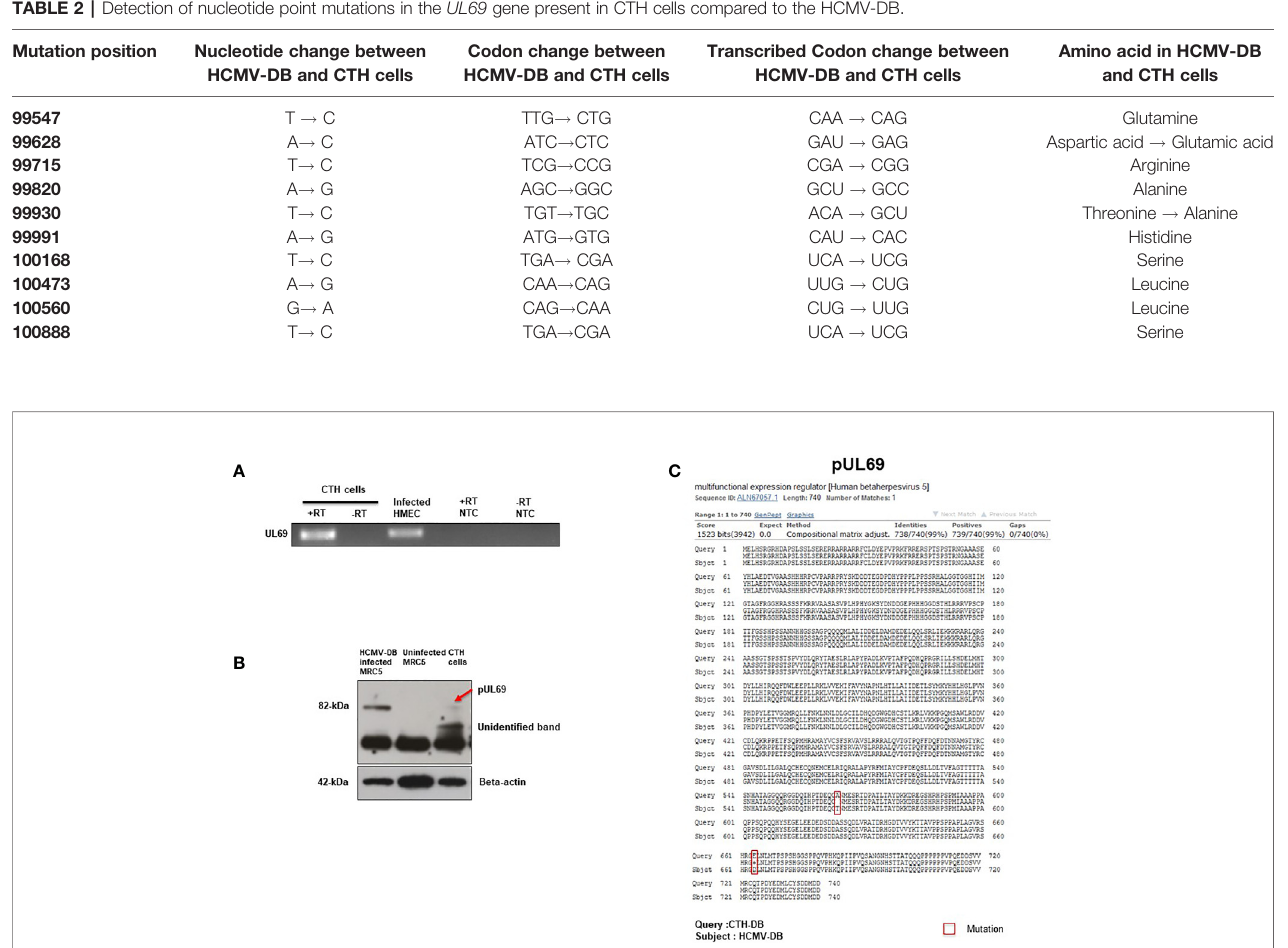
FIGURE 2 | Detection of UL69 transcript and pUL69 protein in CTH cells. (A) RT-PCR assay to detect the presence of UL69 transcript in RNA extracts of CTH cells in the presence (+) and absence (-) of reverse transcriptase (RT). Infected HMECs were used as a positive control and no template control (NTC) as a negative control. (B) Detection of pUL69 protein in CTH cells by western blot. (C) Two residue point mutations present in pUL69 in CTH cells when compared to the original pUL69 from HCMV-DB